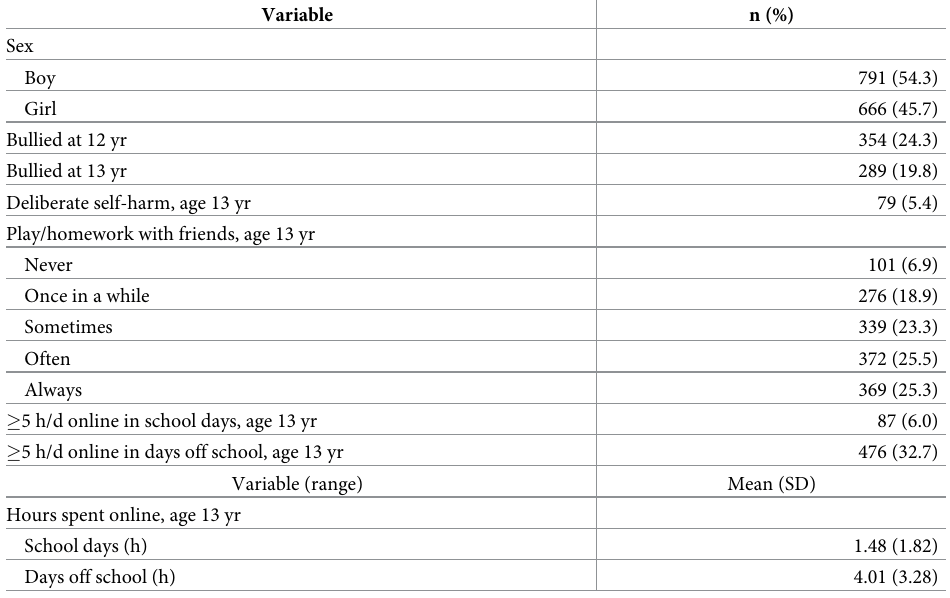
Table 1. Descriptive analysis of the adolescents (n =